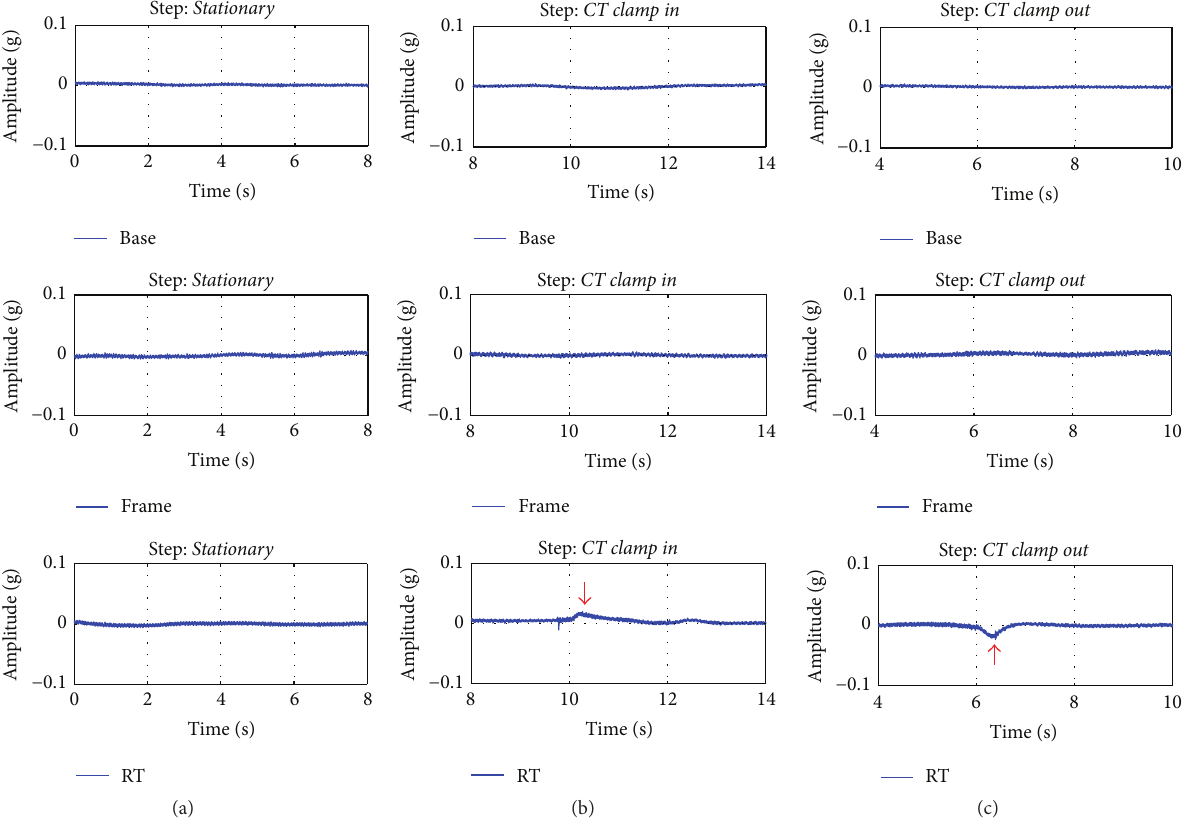
Figure 6: Vibration signals for “ Stationary, ” “ CT clamp in, ” and “ CT clamp out ”